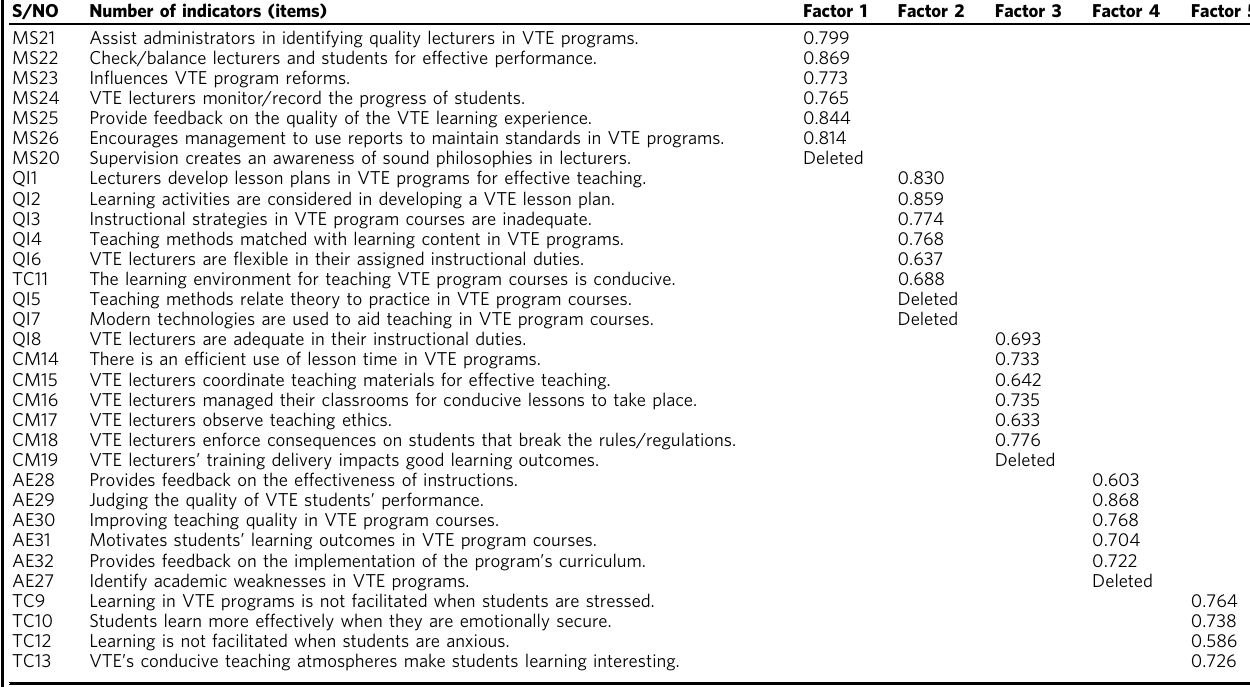
Table 7 Rotated component matrix of process QA factor structures and loadings. S/NO Number of indicators (items)